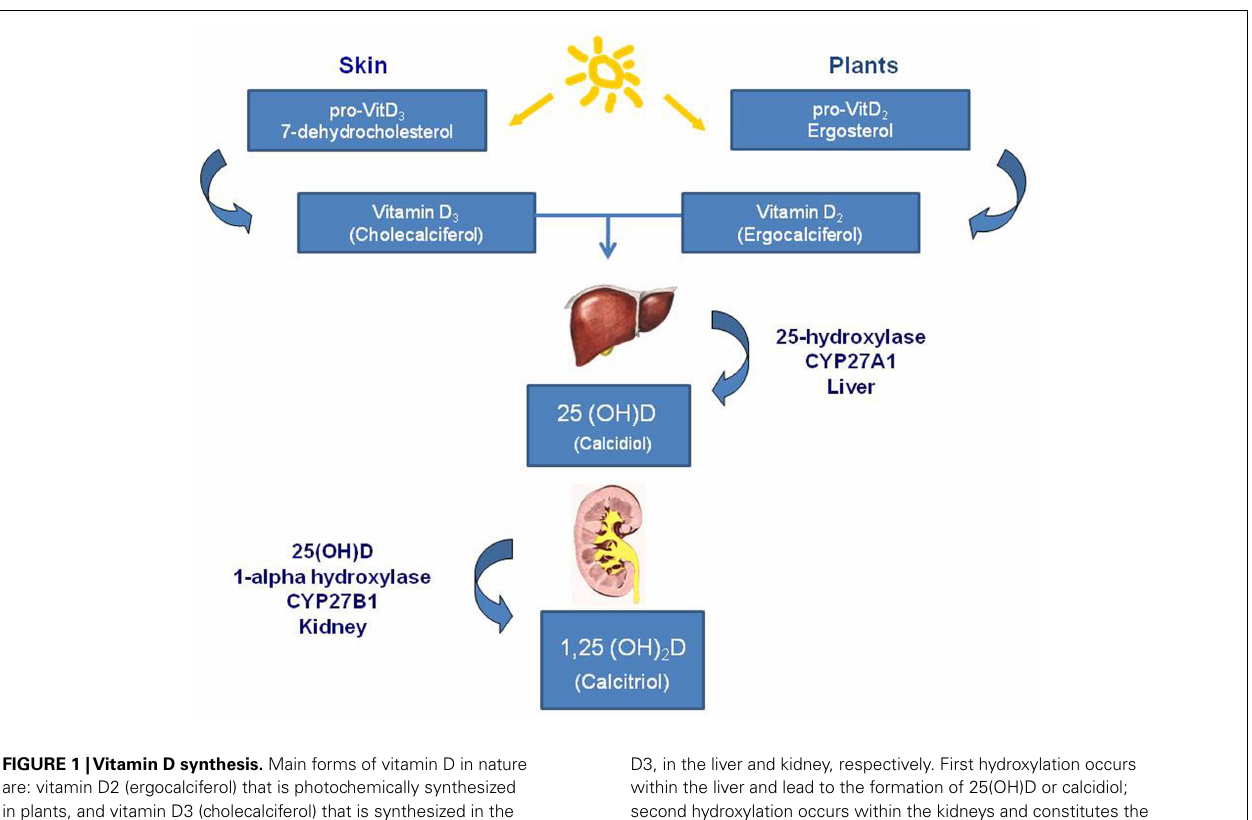
FIGURE 1 |Vitamin D synthesis. Main forms of vitamin D in nature are: vitamin D2 (ergocalciferol) that is photochemically synthesized in plants, and vitamin D3 (cholecalciferol) that is synthesized in the skin of animals and humans in response to sunlight.The synthetic pathway involves 25- and 1-alpha-hydroxylation of vitamin D2 and